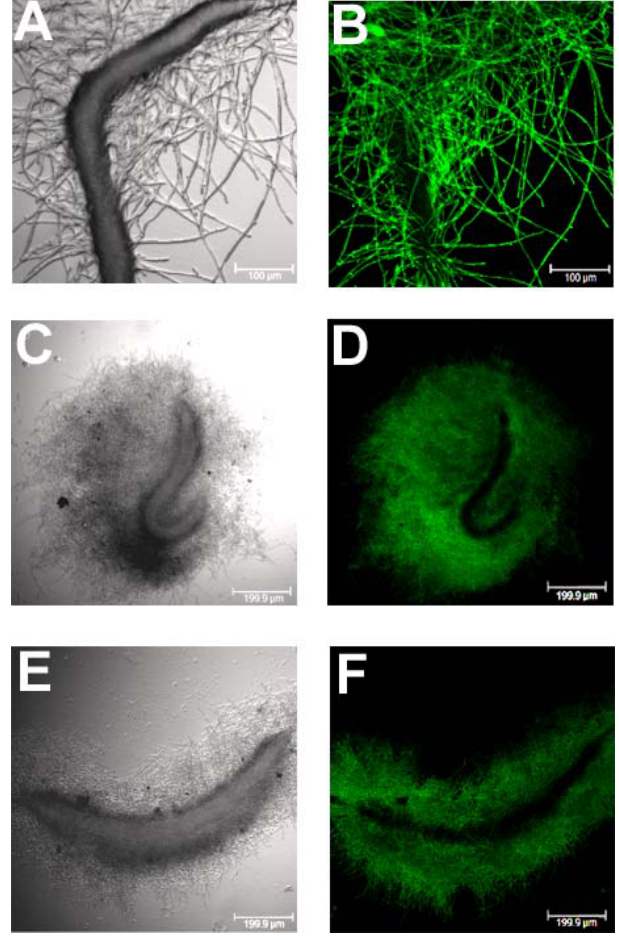
Figure 4. Progression of Filamentation